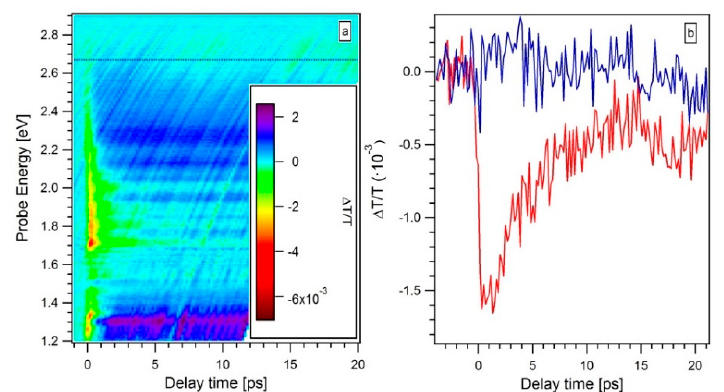
Figure 6. ( a ) Transient transmittivity Δ T/T (E,t) collected on the 5k@ film where the pump and probe pulses are linearly polarized and mutually perpendicular. The inset shows a color scale intensity for the transient transmittance. ( b ) Comparison of the transient transmittance Δ T/T (E = 2.66 eV,t) acquired at a fixed energy of the probe on the 5k@ sample with the pump and probe pulses linearly polarized and mutually parallel (red curve) and perpendicular (blue curve). All the measurements are performed with a pump photon energy of 3.27 eV and with an excitation fluence of 3.5 mJ/cm 2 .